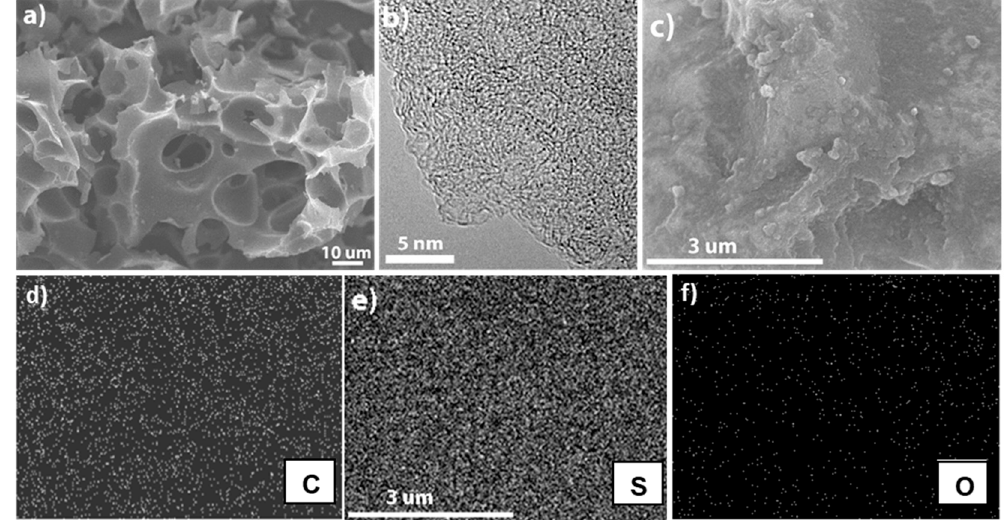
Figure 2. ( a ) SEM, ( b ) HR-TEM images of CSC showing the presence of hierarchical pore